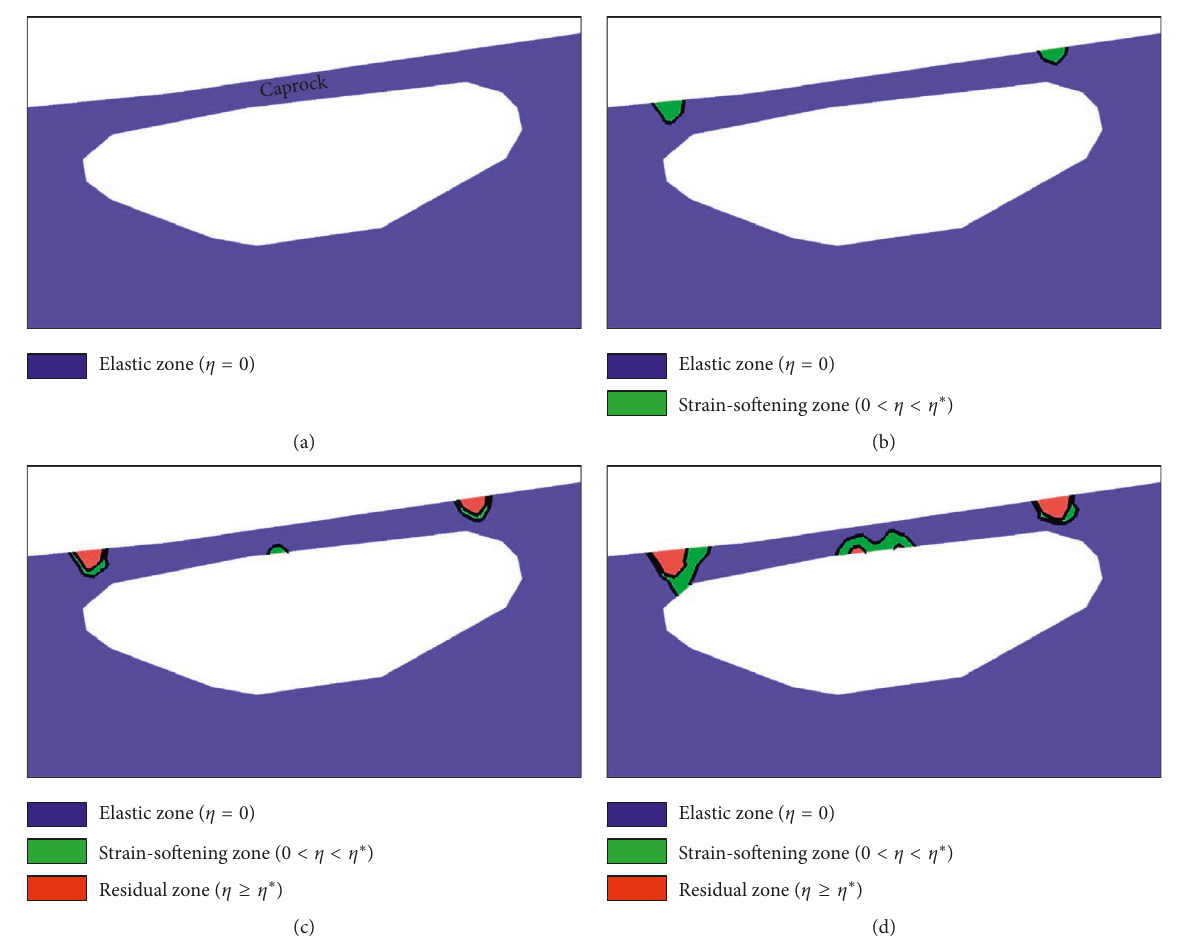
Figure 19: The occurrence of the strain-softening zone and its transition to the residual zone.